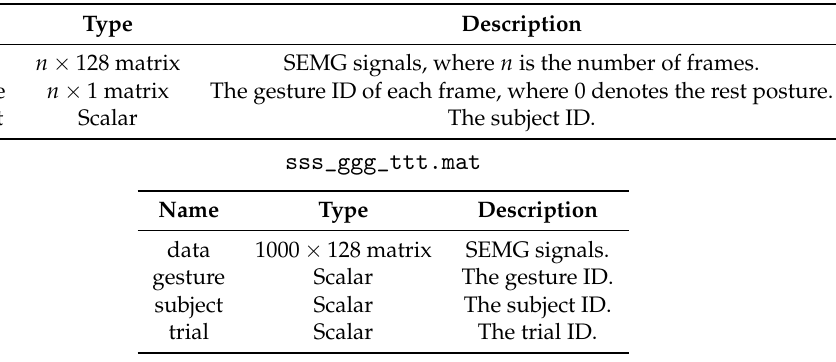
Table 3. Subject ID in each sub-database. Some subjects participated in the acquisition of more than one sub-database. Each subject in DB-b took part in two recording sessions, which are marked with different